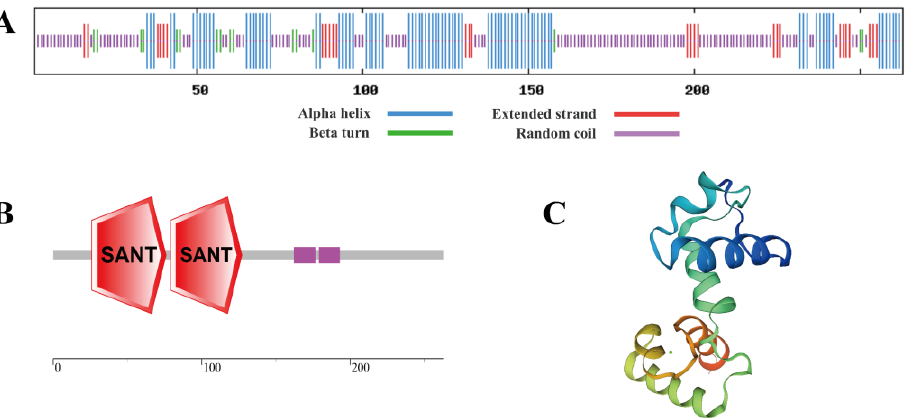
Figure 2. Prediction of Sb MYB12 protein structure and domains. ( A ) Predicted protein secondary structure. ( B ) Predicted protein domains. ( C ) Predicted tertiary structure.